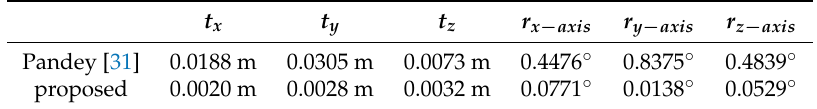
Table 5. Rotation and translation error (25